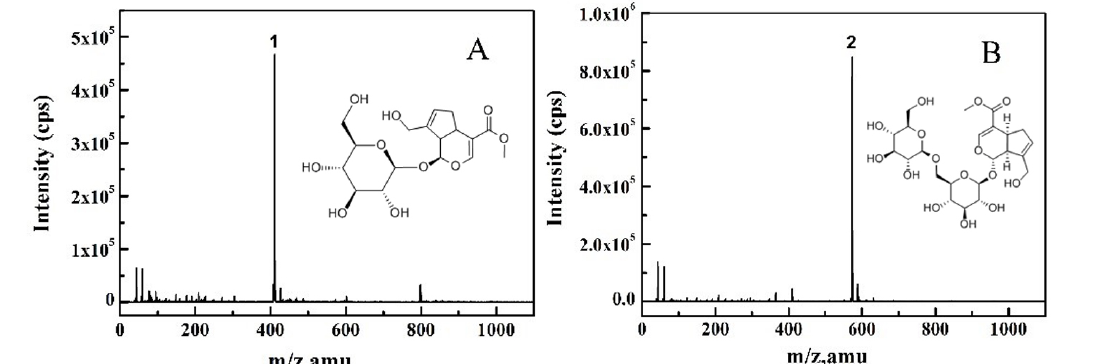
Fig. 2. Mass Spectra of reference solutions, A: TIC of geniposide, peak 1: 410.9 m/z , amu; B: TIC of genipingentiobioside, peak 2: 572.7 m/z ,